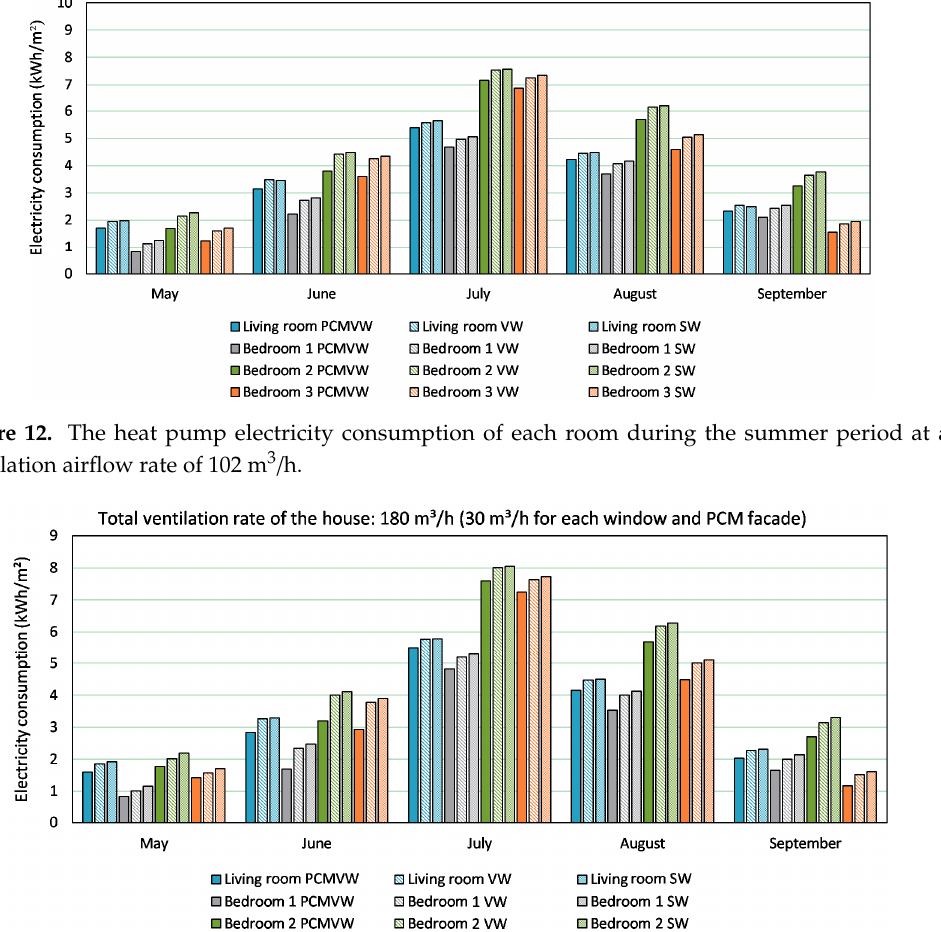
Figure 11. Summer reference case 1 using VW [14]. ( a ) Night time ventilation, when (hour < 7) or (hour > 20:00). ( b )Bypass ventilation , when T indoor > 24 °C . ( c ) Heat mode, when T indoor < 24 °C .